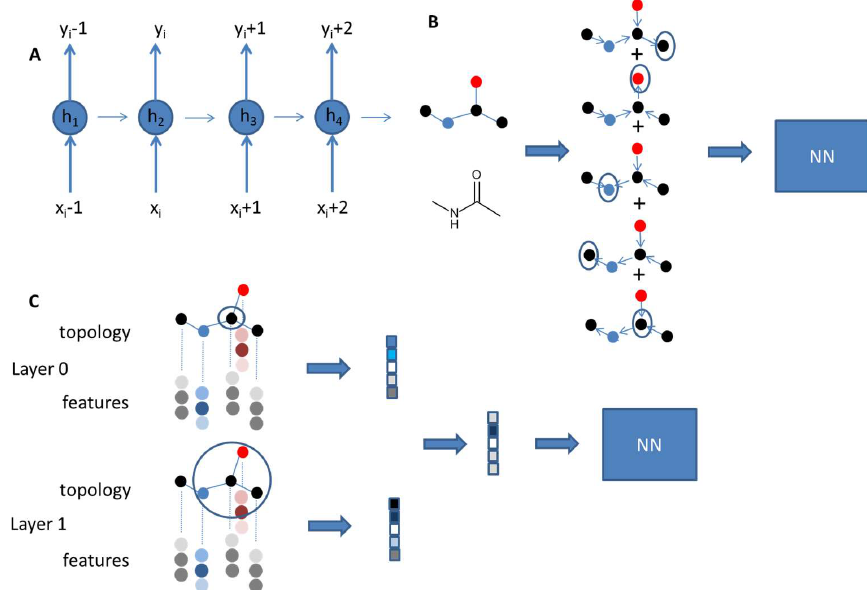
Figure 3. ( A ) Recurrent neural networks (RNNs) use sequential data. The output for the next element